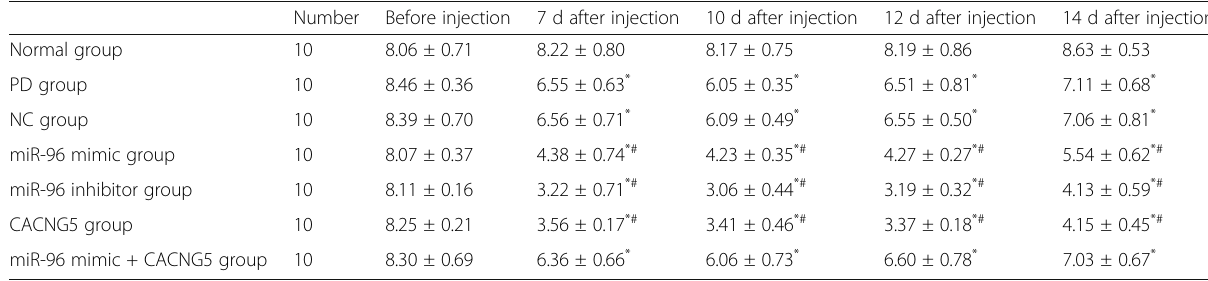
Table 2 Behavioral changes at different time points for mice among seven